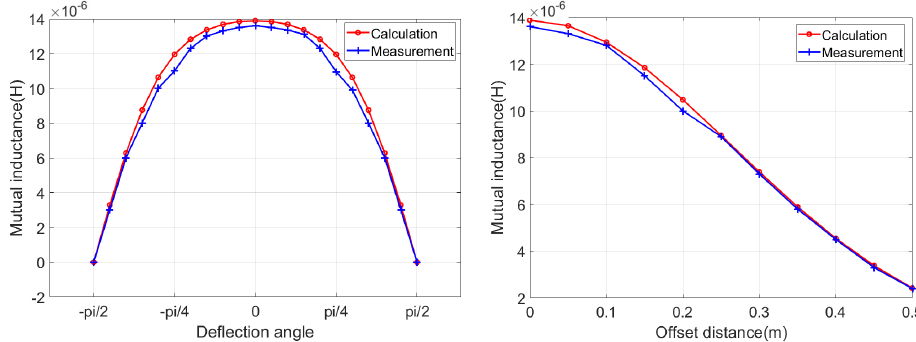
Figure 5. Horizontal offset and angular deflection coils.